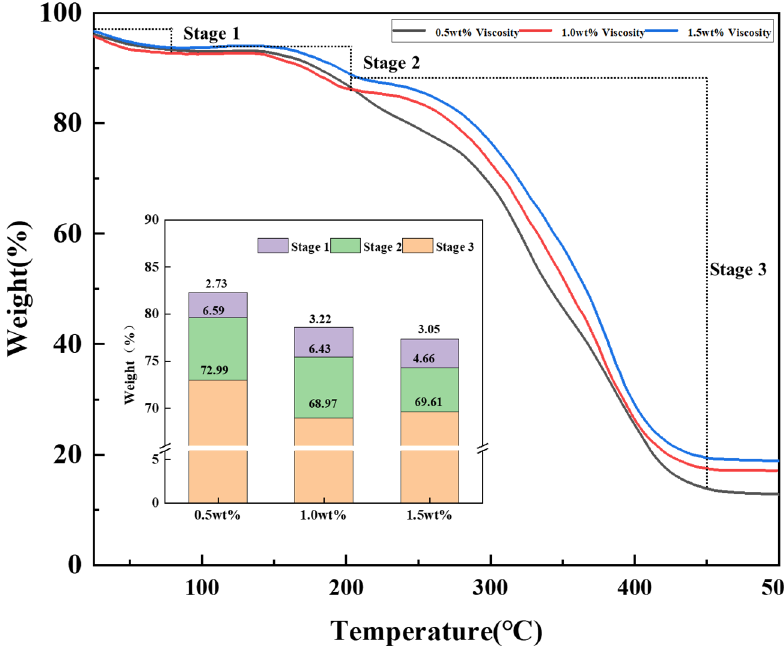
Figure 8. Thermogravimetric curves for different concentrations of ZJL-1.